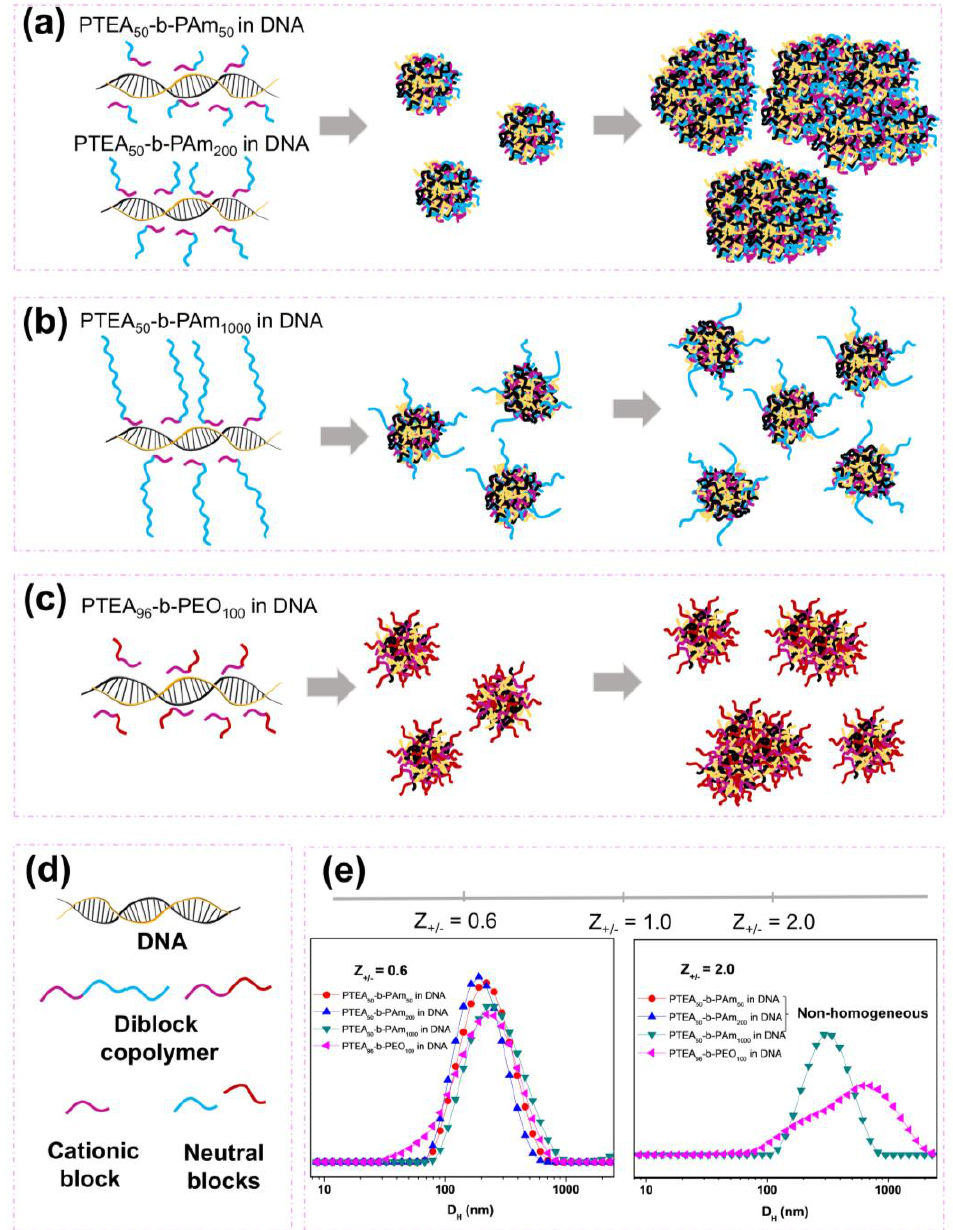
Figure 3. Illustration of the mechanism of interaction for the addition of ( a ) (PTEA) 50 - b -(PAm) 50 , ( d ) Schematic representation of the macromolecules studied: ( e ) DLS results as a function of charge ratio, at Z +/- = 0.6 and 2.0, for the polyplexes studied.